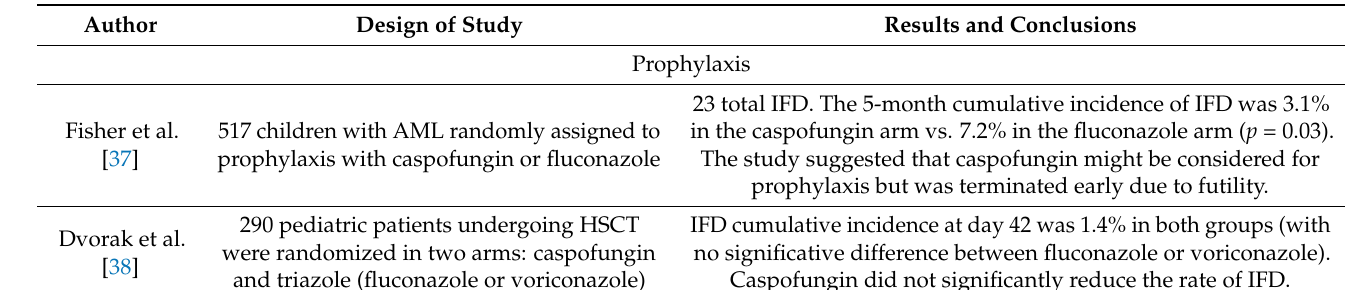
Table 2. Main studies on antifungal prophylaxis, empirical treatment and therapy of candidiasis, aspergillosis and